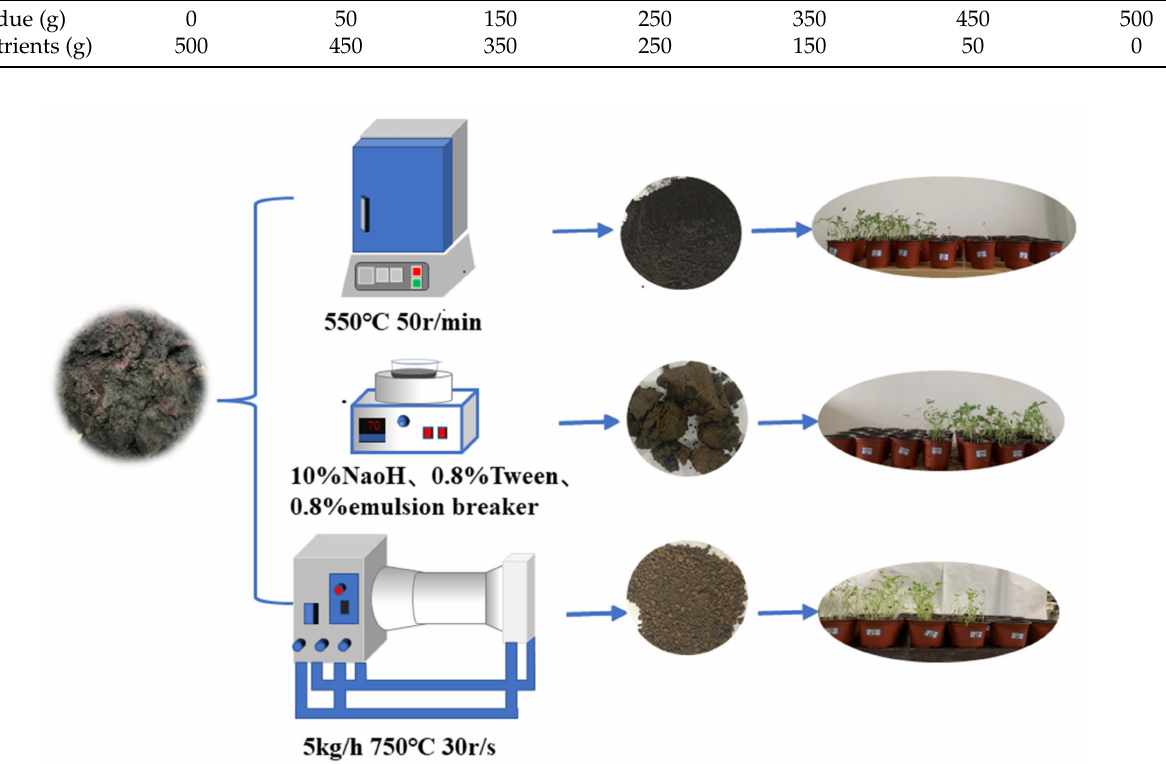
Figure 1. Preparation process and phytoremediation of residues using different heat treatment